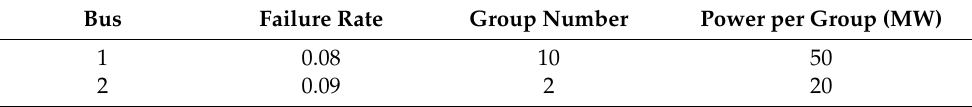
Table 1. Power generation per group, number of generators per power plant and failure Table 3. Statistical parameters of lines/transformers of IEEE-14 system.